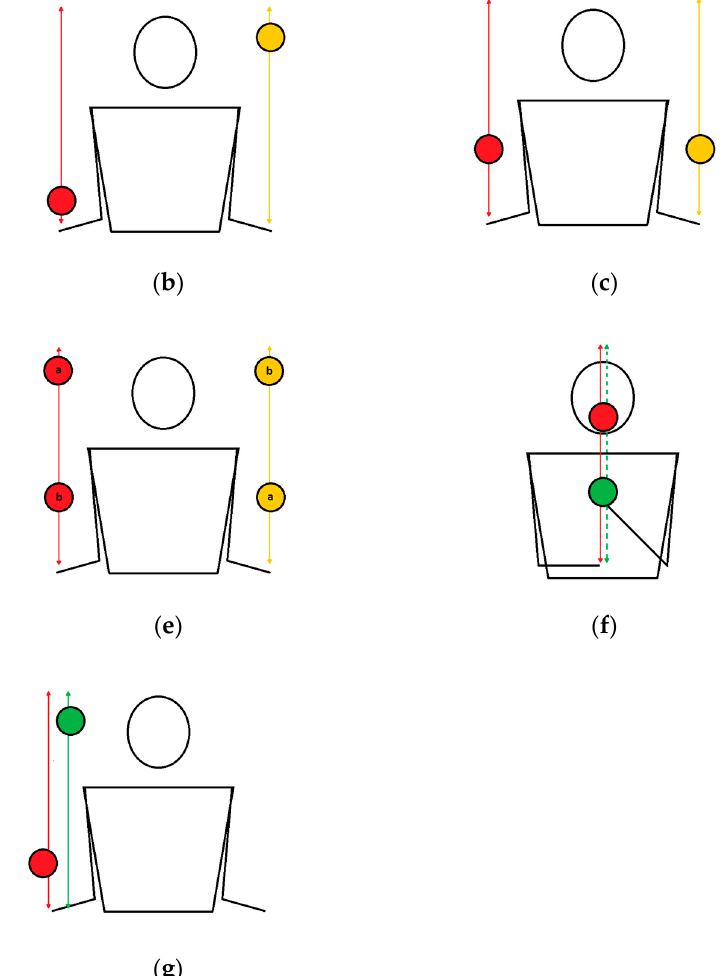
Figure 1. Column juggling exercises: ( a ) the one-handed column; ( b ) two-handed alternate columns; ( c ) two-handed simultaneous columns; ( d ) two-handed simultaneous columns at three levels; ( e ) two-handed simultaneous columns at different levels; ( f ) fake columns; ( g ) two-balls-in-one-hand columns.